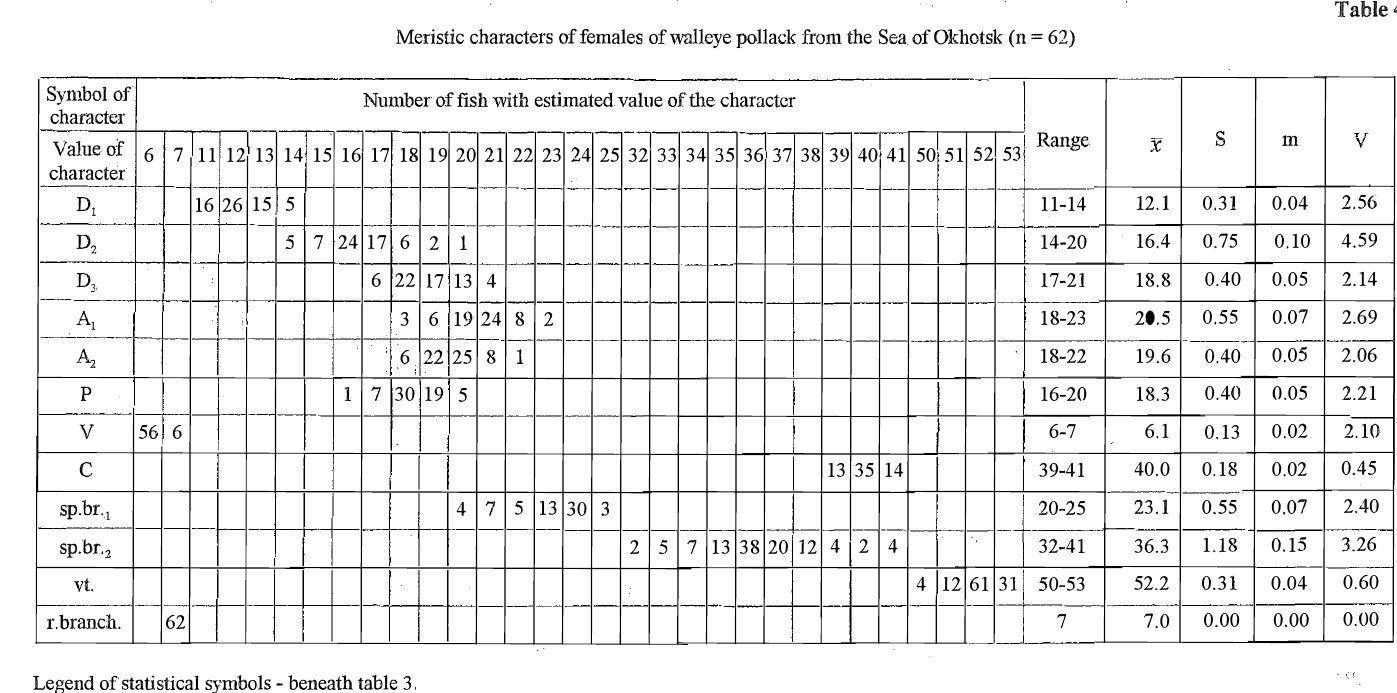
Meristic characters of females ofwalleye pollack from the Sea of Okhotsk (n = 62)